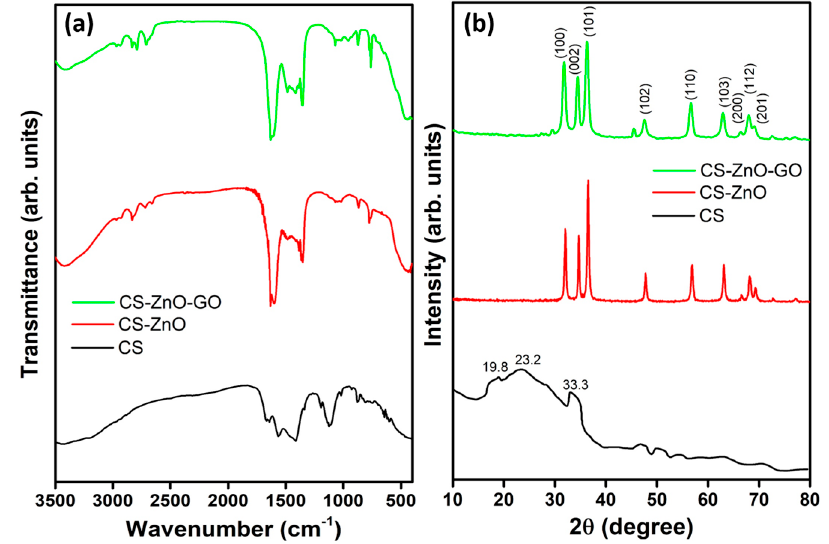
Figure 2. ( a ) Fourier transform infrared (FTIR) and ( b ) X-ray diffraction (XRD) spectra of CS and the